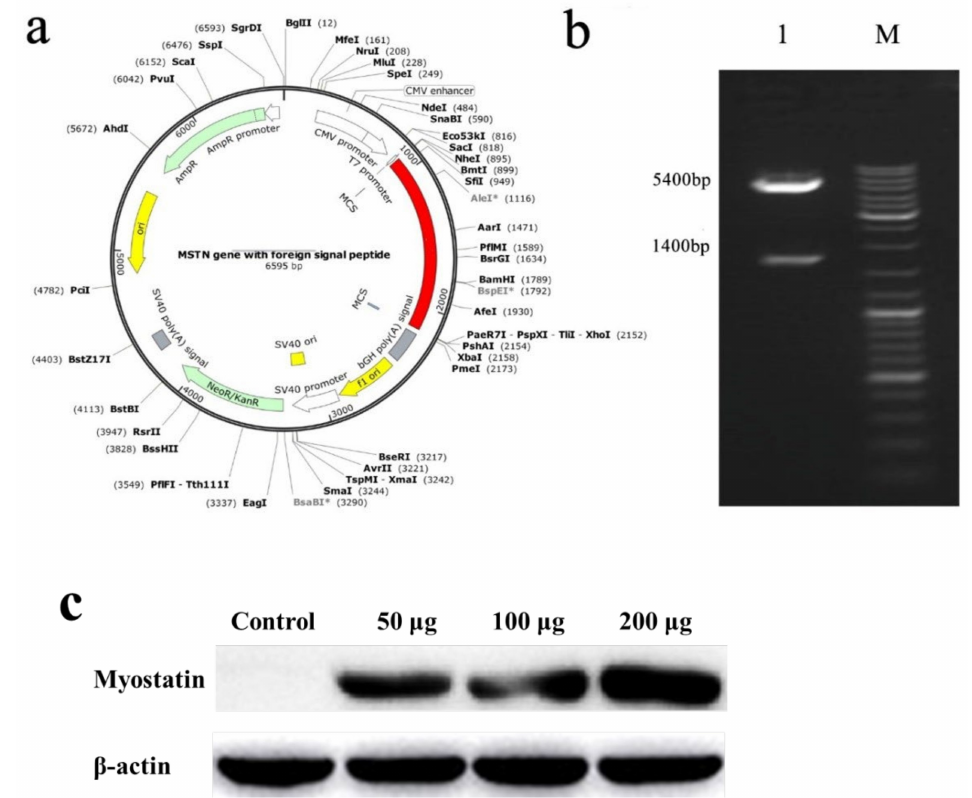
Figure 1. ( a ) Schematic diagram of nucleic acid vaccine. ( b ) Double enzyme digestion electrophero- gram. 1: Plasmid digestion band, 1400 and 5400 bp; M: DNA marker. ( c ) Western blotting analysis of HBSAg protein in muscle of vaccinated E. coioides